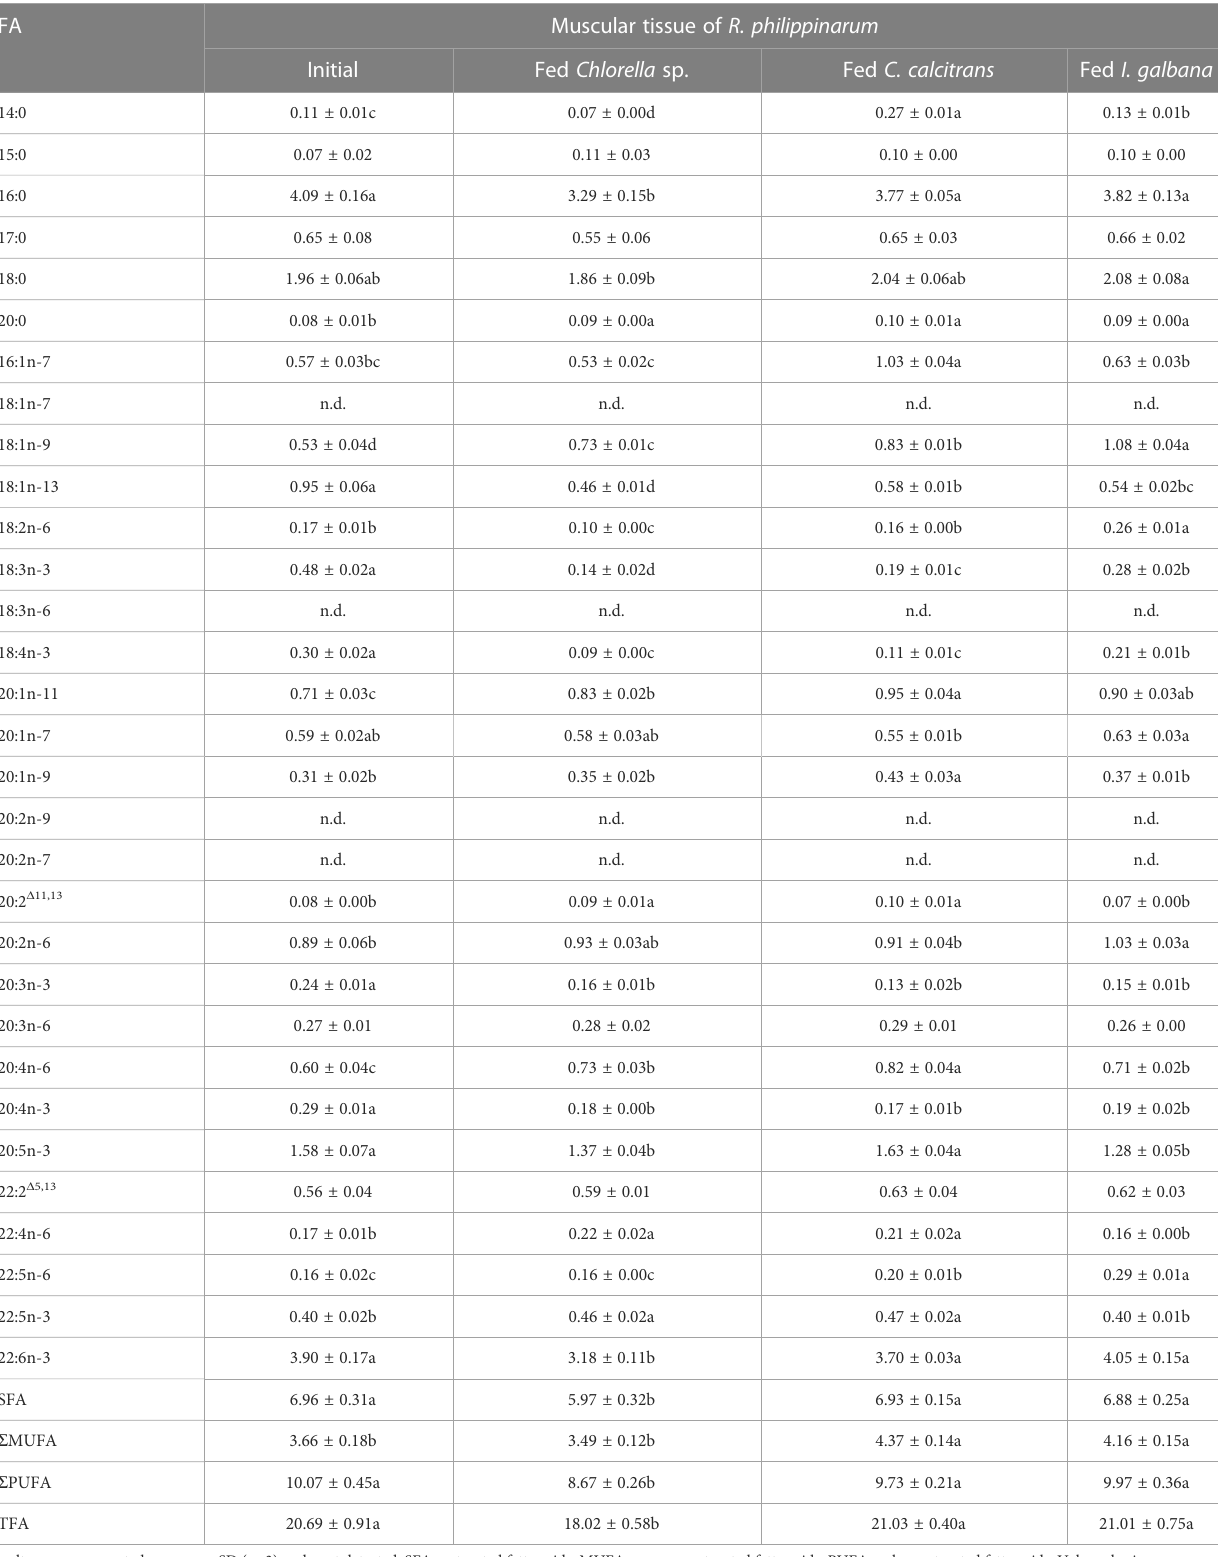
Results were represented as mean ± SD (n=3). n.d., not detected; SFA., saturated fatty acids; MUFA., monounsaturated fatty acids; PUFA, polyunsaturated fatty acids. Values sharing a common letterinthesamegrouparenotsigni fi cantlydifferent(P ≥ 0.05).SFA,saturatedfattyacids;MUFA,monounsaturatedfattyacids;PUFA,polyunsaturatedfattyacids(doublebonds ≥ 2);TFA,total fatty acid; “ n.d. ” , not